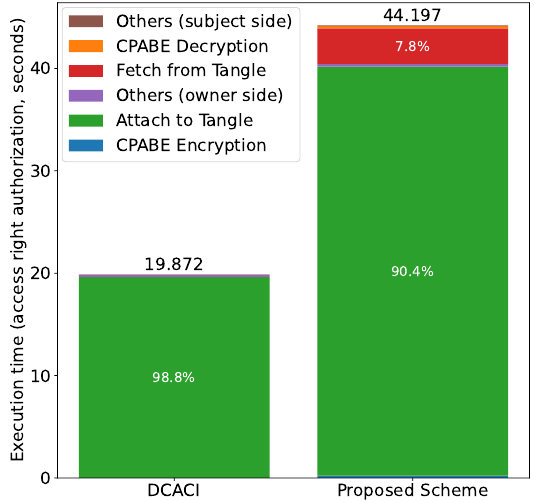
Figure 23. Comparison with DCACI: access right authorization (with breakdown).